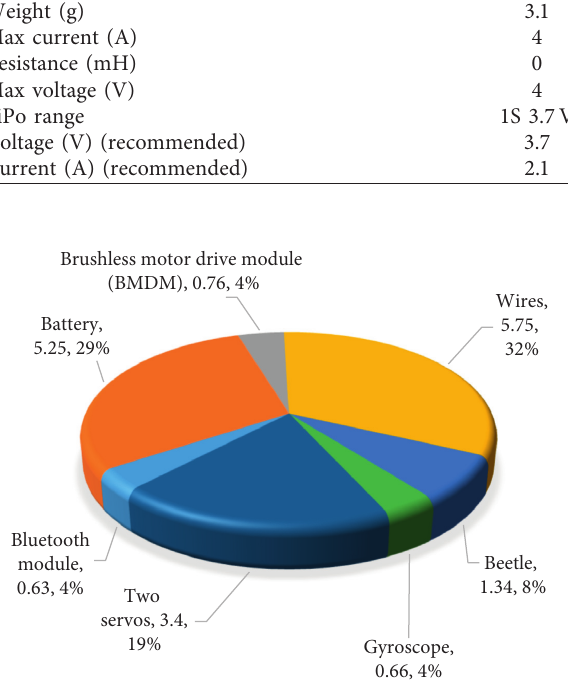
Figure 10: The weight of every part. The total weight is 17.79g.